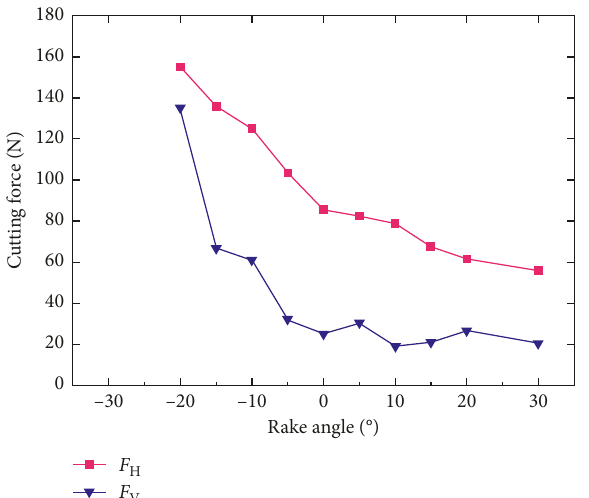
Figure 12: Cutting forces at different rake angles ( v 0.4 a c (cid:28)